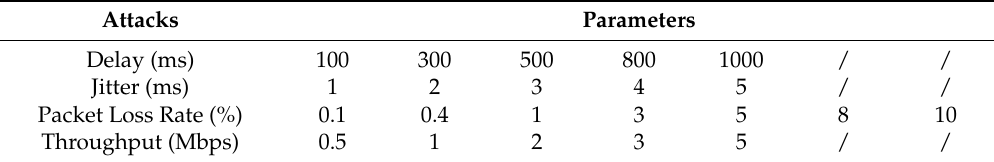
Table 16. The video attacks simulated by the ReTRiEVED dataset.